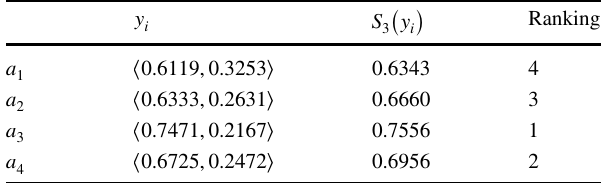
Table 12 Ranking by the PF-FMF